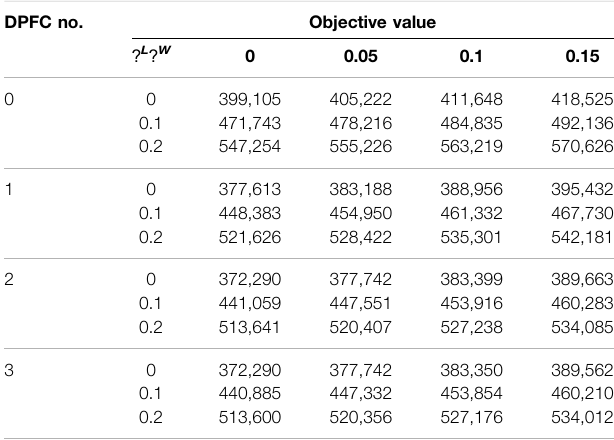
TABLE 2 | Objective values under different intervals considering the optimal DPFC. DPFC